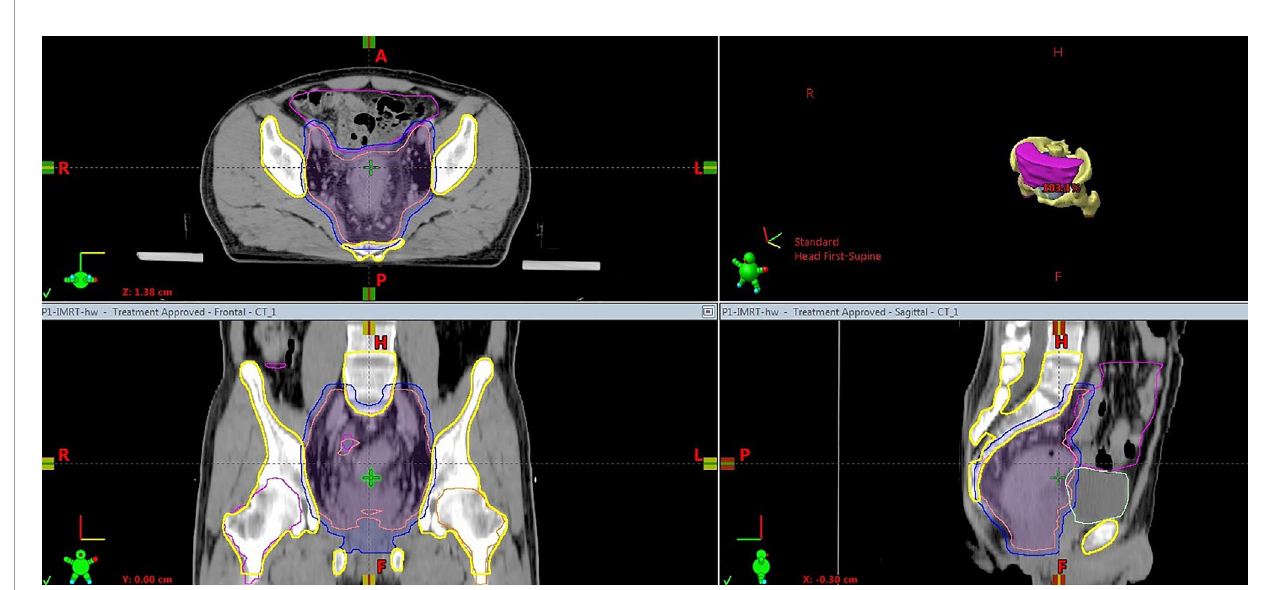
FIGURE 1 | Computed tomography slice showing the delineation of target volume and OARs. Pink solid, clinical target volume; blue solid, planning target volume; yellow, pelvic bone marrow; magenta, small bowel; light green,